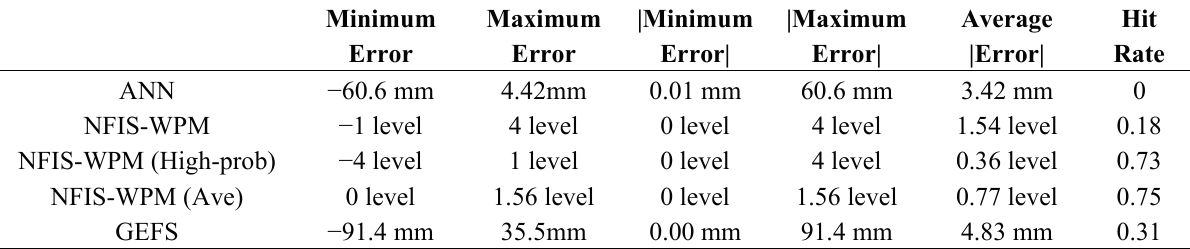
Table 6. Comparison between ANN and neural fuzzy inference system-based weather prediction